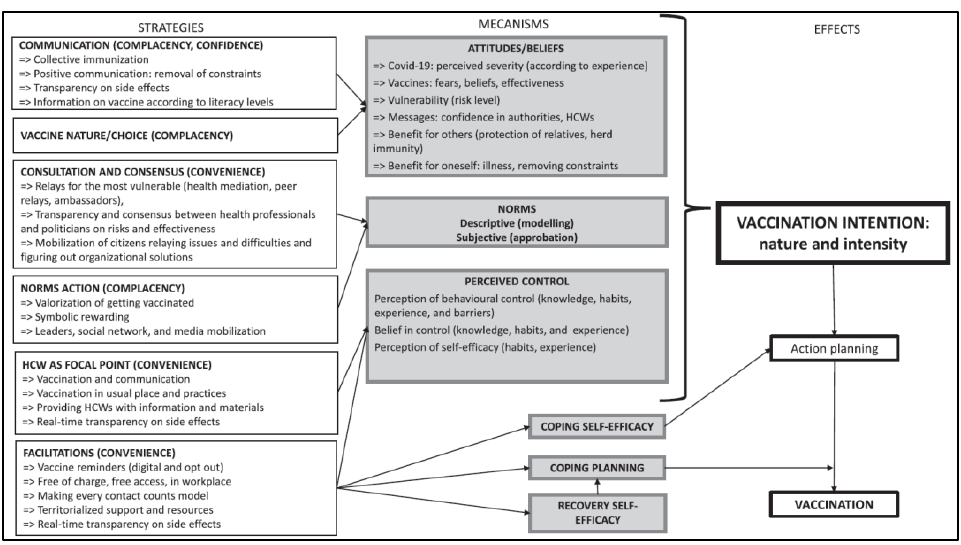
Figure 1. Meta-model: strategies to overcome COVID-19 vaccine hesitancy [16].